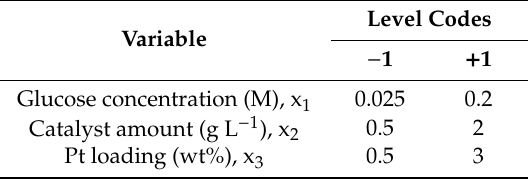
Table 1. Experimental domain for the 2 3 factorial design.